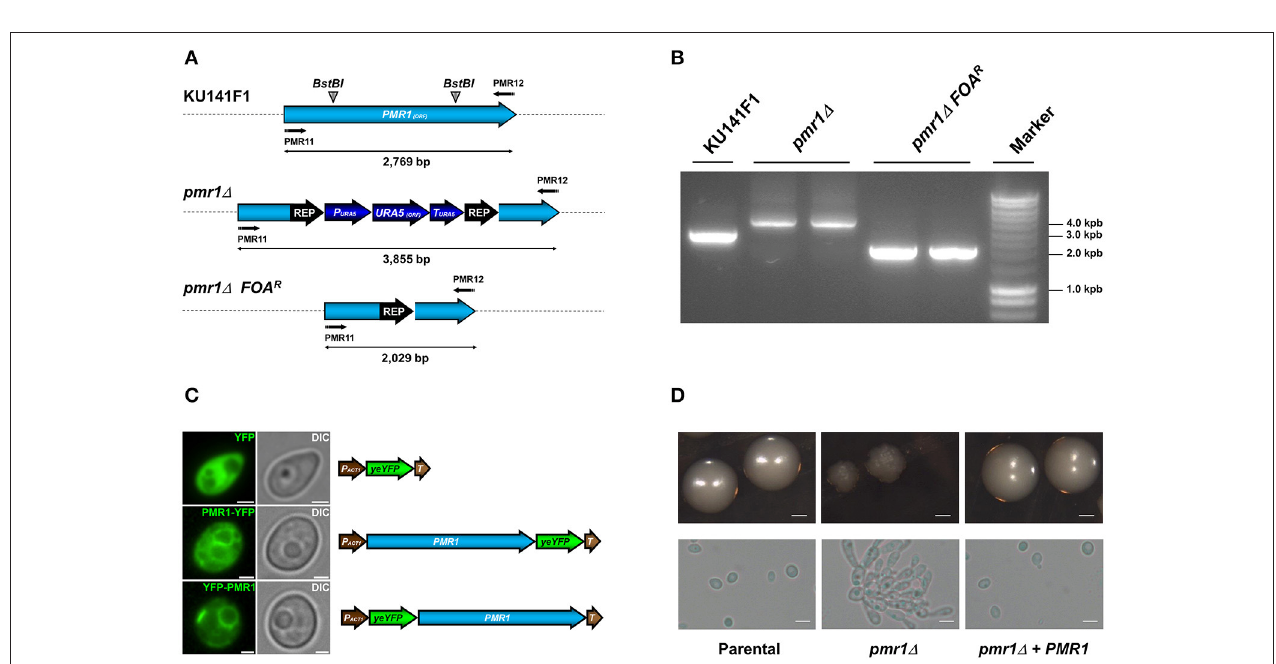
FIGURE 2 | Generation of the C. guilliermondii mutants used in this study and colony and cell morphology. (A) Schematic representation of the wild type and disrupted PMR1 loci. The PMR1 was disrupted in the strain KU141F1 using the URA5 blaster system. (B) Generation of the null mutant was confirmed by PCR reactions using the primer pair PMR11 5 ′ -CTGAGAGGATCCATGACAGAGAACCCGTTCGATGTG-3 ′ and PMR12 5 ′ -CTGAGAACTAGTTACGCTGTAGCTGACTCCAT TCAT-3 ′ that amplifies the whole PMR1 locus. All the generated amplicons displayed the expected sizes, as indicated in (A) of the figure. (C) Subcellular localization of YFP alone, Pmr1-YFP and YFP-Pmr1 fusion proteins in the pmr1 1 strain. Scale bar = 2 µ m. (D) Colony and cell morphology of C. guilliermondii strains. Cells were grown on SC medium at 30 ◦ C for 36h, scale bar = 1 mm. Alternatively, strains were cultured in SC broth at 30 ◦ C for 18h; scale bar = 10 µ m. The strains used are: KU141 (Parental), HMY134 ( pmr1 1 ) and HMY138 ( pmr1 1 + PMR1